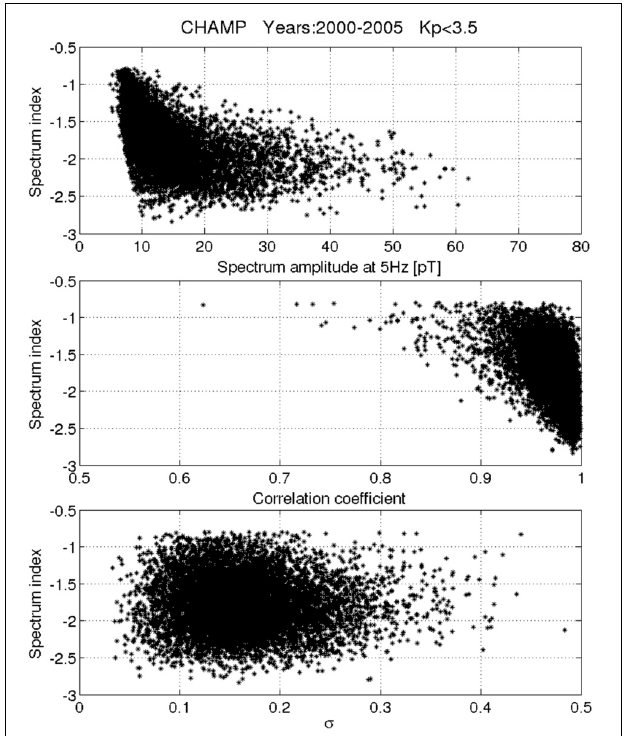
FIGURE 7 | Quality properties of the intermediate-scale spectral indices. The top frame shows the dependence of the index on signal amplitude, the middle frame the quality of linear correlation for the different index values, and at the bottom a possible dependence of the index value on the data point scatter, σ , contributing to the line fit. Almost all the events with correlation coefficients less than 0.9 have small amplitudes ( < 15pT @